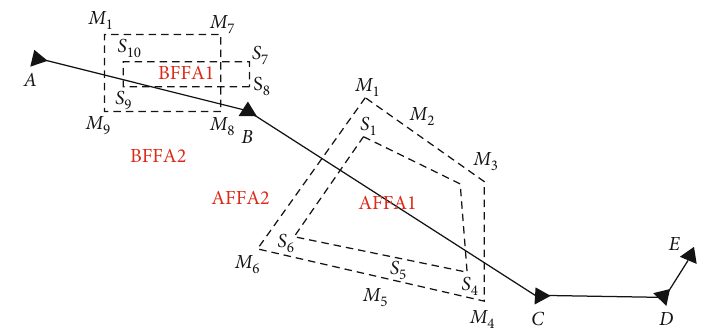
Figure 10: Dynamic fl ight-restricted area on the Guiyang – Guangzhou route in China.